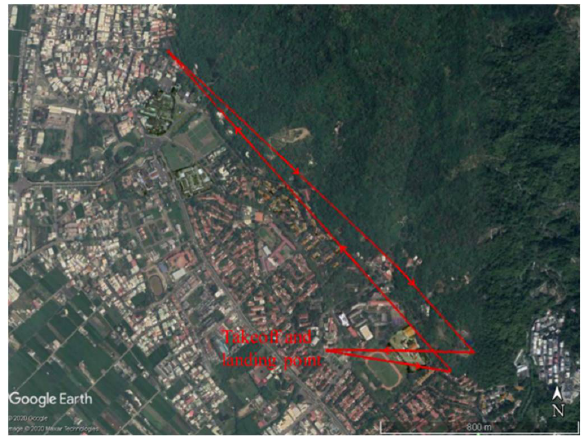
Figure 7. UAV flight trajectory. Table 1. The defined scenarios.